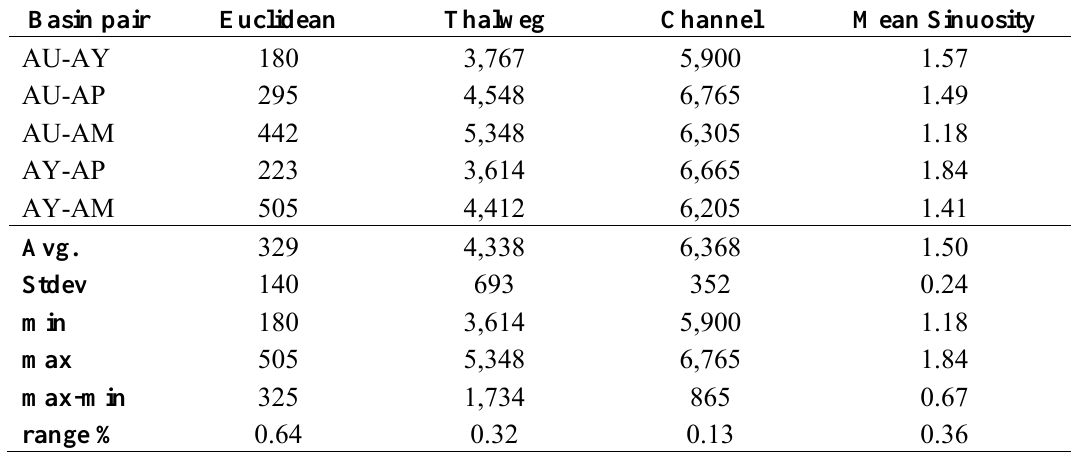
Table 2. Distance estimates (km) between downstream collection sites in three basins of the Fitzcarrald Arch, southeastern Peru. AU = Alto Ucayali at Sepahua; AP = Alto Purús